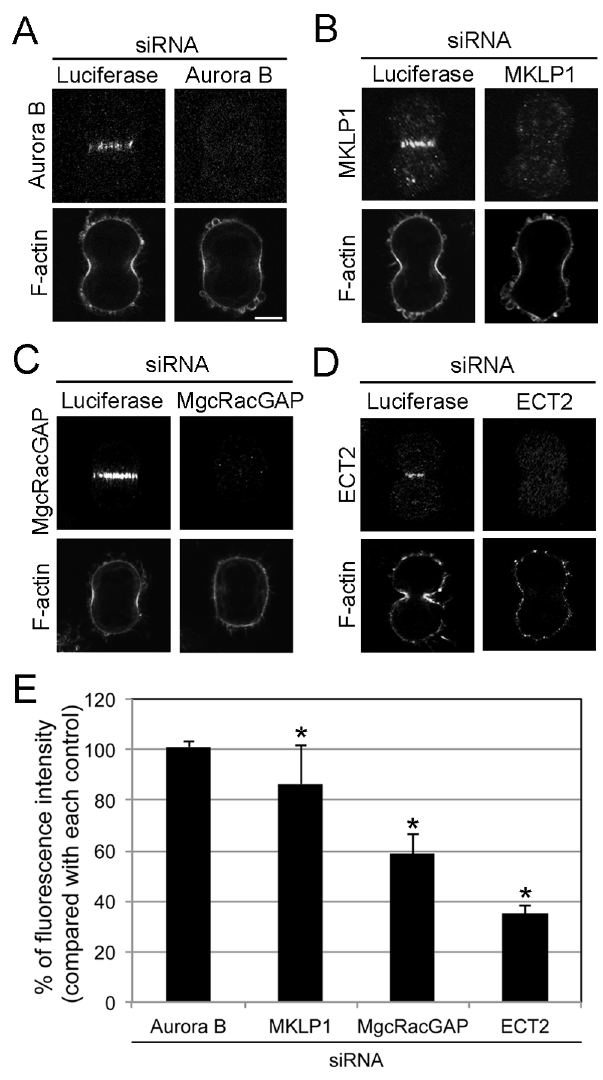
Figure 6. Aurora B and Rho signaling proteins are independent regulators of the localization of F-actin to the contractile ring. HeLa cells treated with siRNAs targeting luciferase, Aurora B (A), MKLP1 (B), MgcRacGAP (C), or ECT2 (D) were fixed and immunostained as indicated. Bar, 10 m m. (E) Quantitative analysis of F-actin fluorescence at the contractile ring in cells treated as indicated. All values are presented as a percentage of the control. Error bars indicate 6 SEM. *, p , 0.05 ( t - test). n $